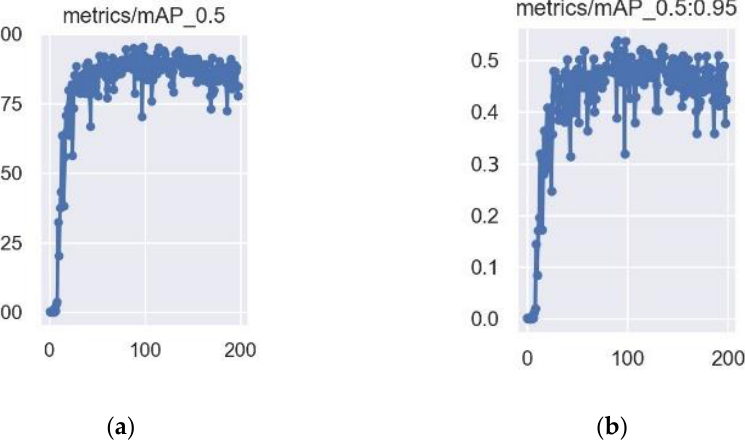
Figure A17. The precision/recall curve and F 1 Score /confidence curve of Improved YOLOV5: ( a ) PR_curve; ( b ) F1_curve.